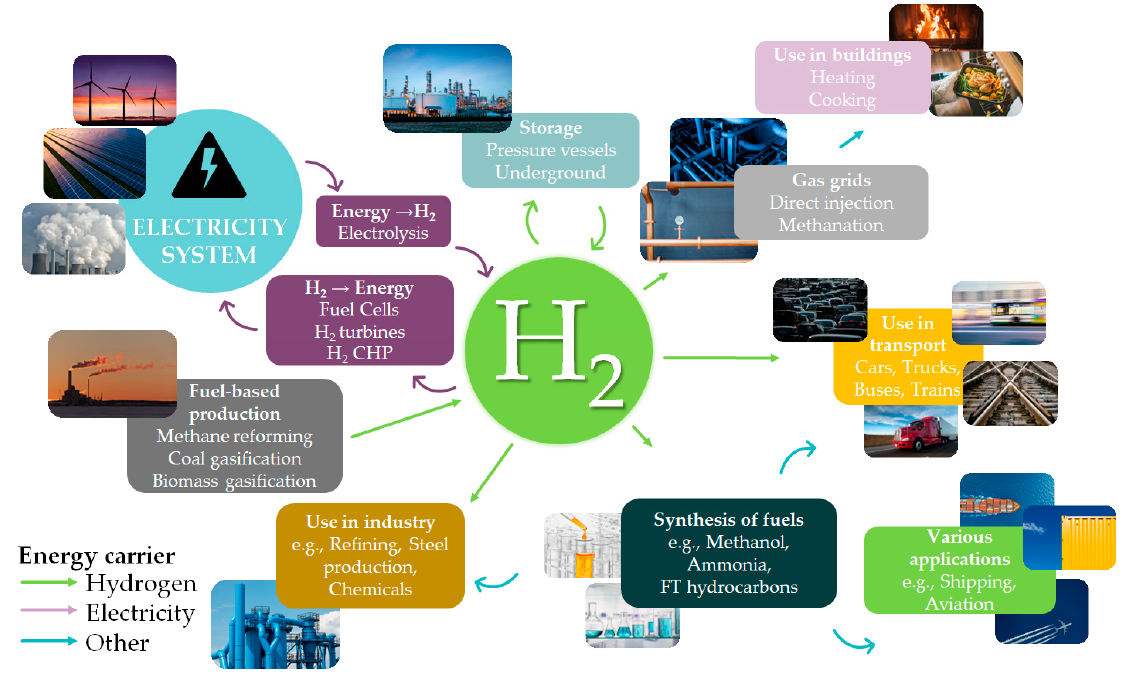
Figure 1. H 2 production and usage pathways.